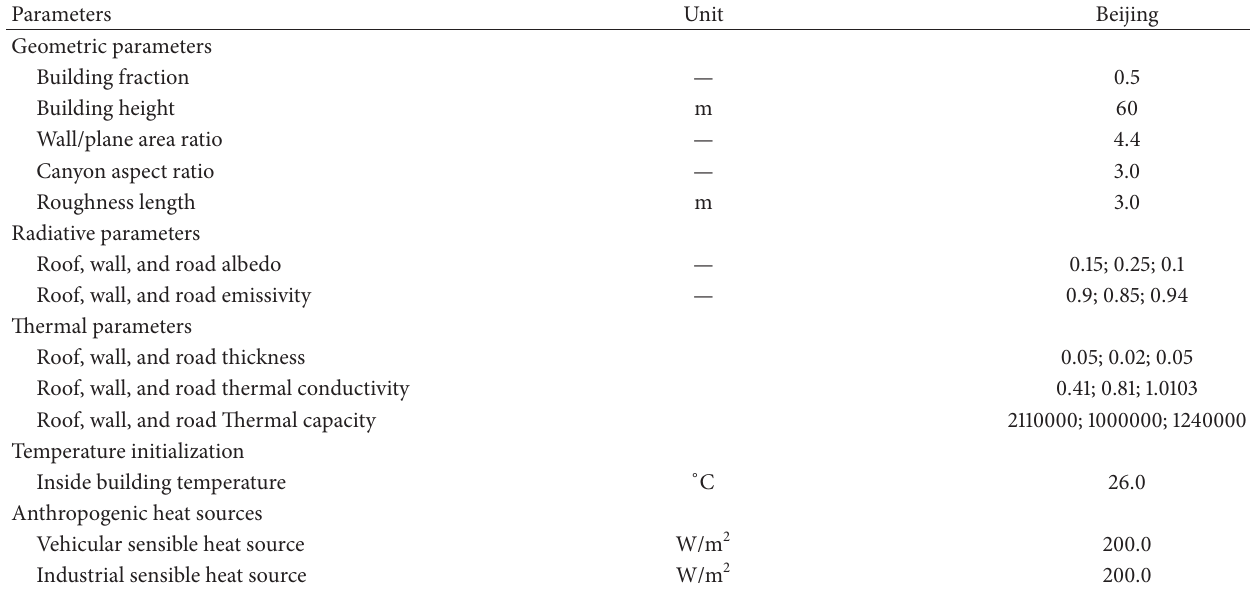
Table 2: Input parameters for the TEB scheme in